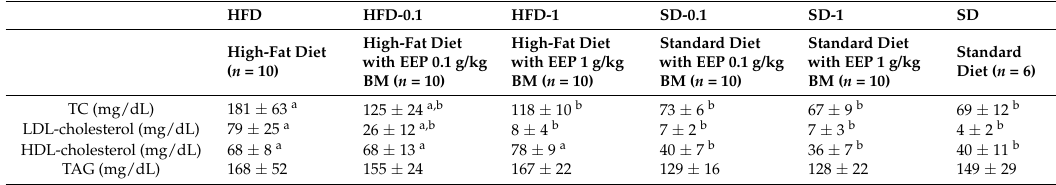
Table 1. Lipid profile of C 57 BL 6 mice.